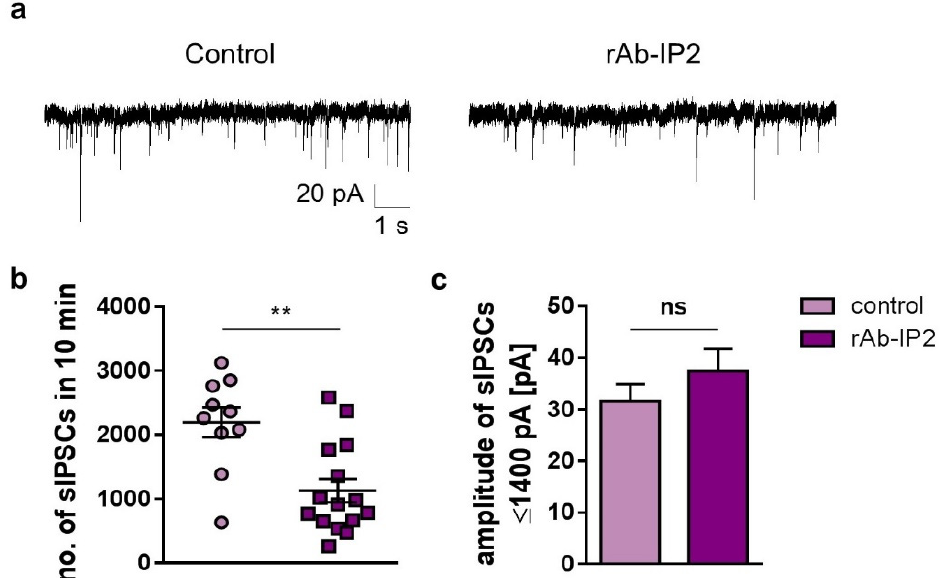
Figure 1. The recombinant GABA A receptor autoantibody rAb-IP2 reduced the number of sponta- neous inhibitory postsynaptic currents (sIPSCs) generated in CA1 pyramidal neurons. ( a ) Exemplary traces depict the GABAergic synaptic transmission in rAb-IP2-incubated pyramidal neurons and controls. Notably, the exemplary traces are cropped at 600 pA to simplify illustration and do not represent the full high-amplitude currents with an amplitude > 1400 pA, which were very likely contaminated with Na + currents and were not GABA-mediated. ( b ) Scatter plot showing that the number of sIPSCs recorded in 10 min decreased upon rAb-IP2 incubation in comparison with the control. ( c ) Bar graphs showing the amplitude of sIPSCs in rAb-IP2-incubated neurons and controls. The amplitude of sIPSCs ≤ 1400 pA was not altered by rAb-IP2 incubation. ** p < 0.01, ns: not signif- icant.